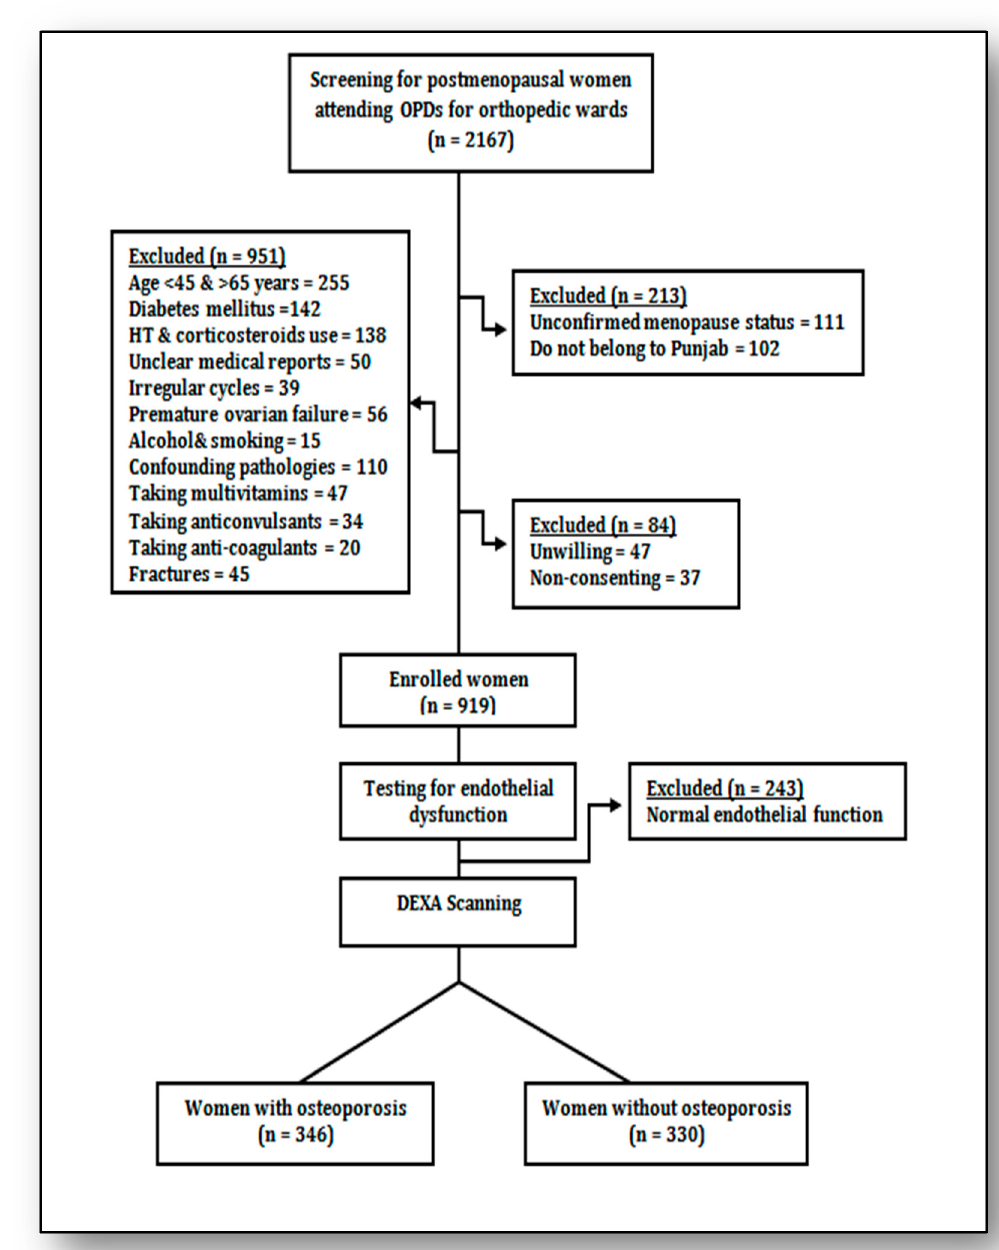
Figure 1. Showing data collection protocol.